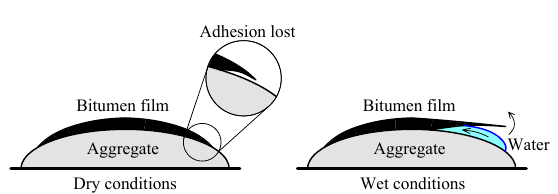
Figure 1. Adhesion lost between binder and aggre- gate in presence of